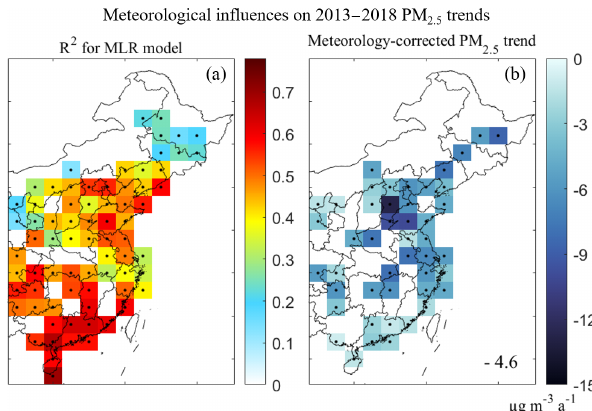
Figure 5. Resolving meteorological influences on PM 2 . 5 2013– 2018 trends in China. Panel (a) shows the fraction of detrended and deseasonalized variance in 10d PM 2 . 5 means explained by the stepwise multilinear regression (MLR) meteorological model. Panel (b) shows the meteorology-corrected trends to be compared to the trends in the original data shown in Fig. 1. Number inset in (b) is the trend in mean PM 2 . 5 over the study region (same definition as in Fig. 1). Dots indicate significant correlations ( p < 0 . 05) in (a) and significant trends ( p < 0 . 05) in (b)